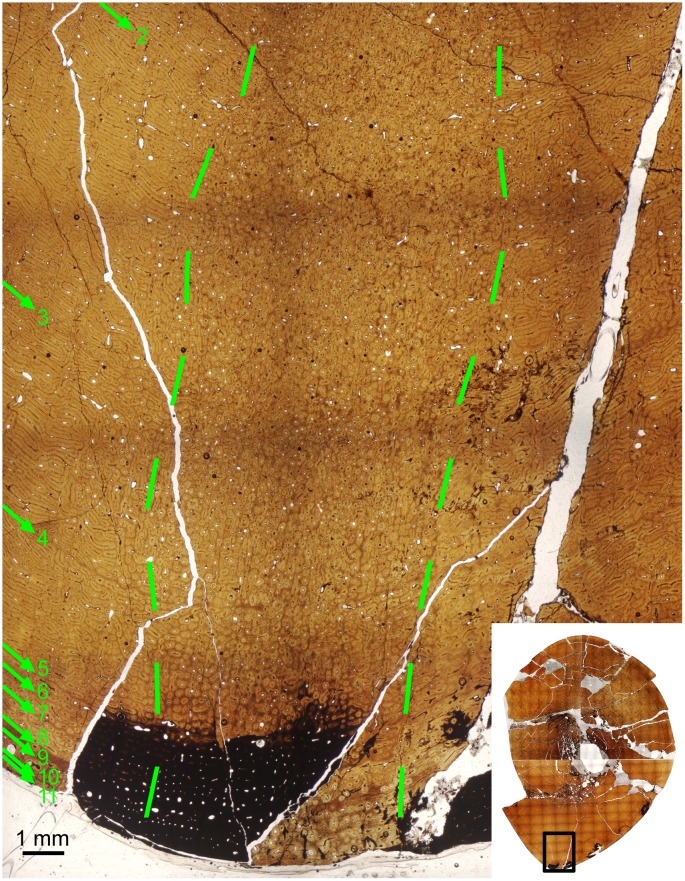
Remodeled “fountain” of secondary osteons on anterolateral side of cortex, MOR 2919 tibia.Margins of the remodeled region are indicated with dashed green lines. Numbered green arrows identify lines of arrested growth. Dark areas near edge of cortex are sections of bone that began to separate from the slide, requiring additional adhesive. Black box on the thumbnail image on lower right indicates location of Fig 27 within the entire tibial cross-section. A high-resolution version of this figure is available at http://www.morphobank.org/index.php/Projects/Media/id/377389/project_id/2157.